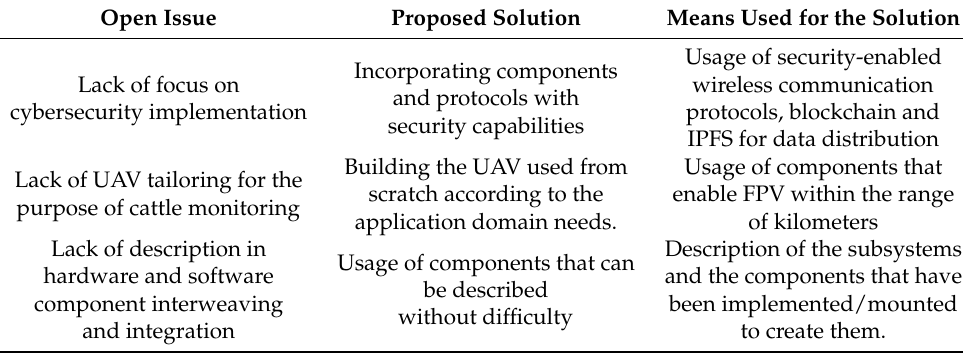
Table 2. Advantages of the proposed system compared to the open issues identified.